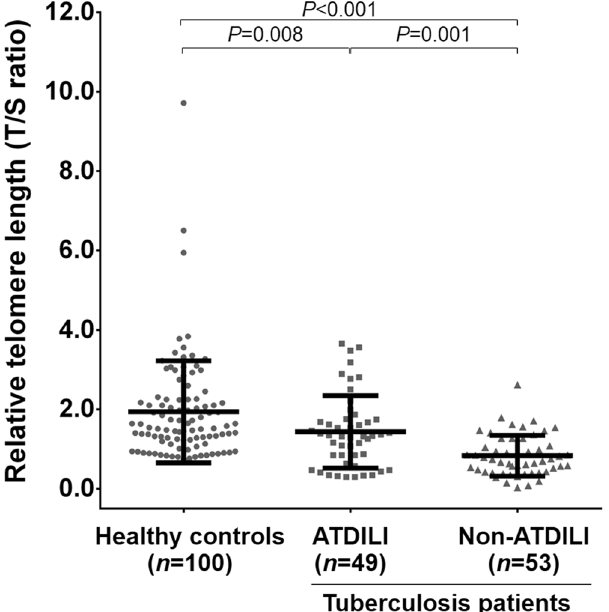
Figure 1. RTL in blood leukocyte of healthy controls and tuberculosis patients with and without ATDILI. Abbreviations: ATDILI, anti-tuberculosis drug-induced liver injury; RTL, relative telomere length.